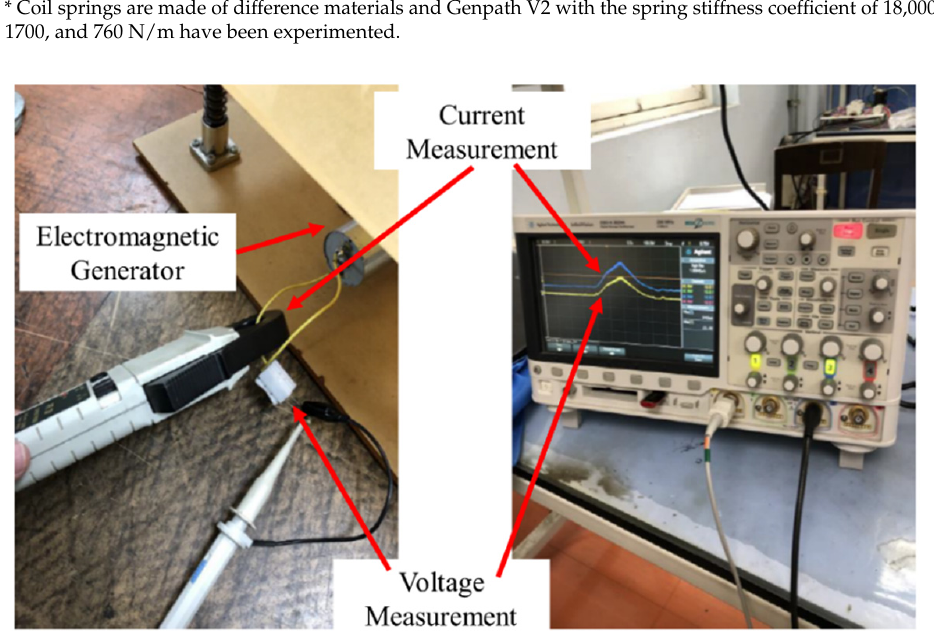
( b ) Figure 11. Voltage, current, power, and energy of the Genpath V2 from experiment and simulation when 𝐾 = 1700 N/m: ( a ) voltage and current of the Genpath V2. ( b ) power, and energy of the Genpath V2. Table 6. Performances of the Genpath V1 [24] and the Genpath V2 when K = 1700 N/m Variables